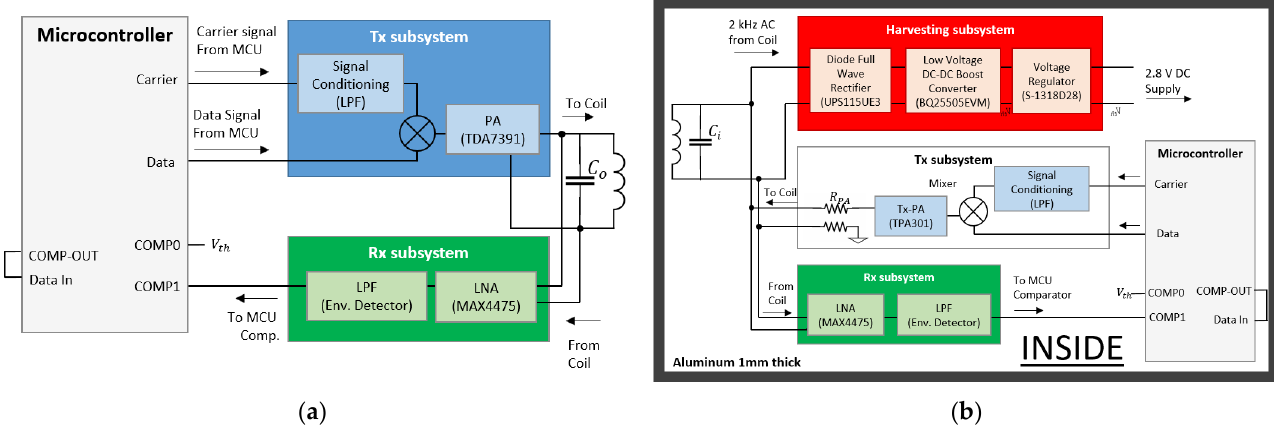
Figure 14. Fully integrated communication system: ( a ) outside, and ( b ) inside subsystem.